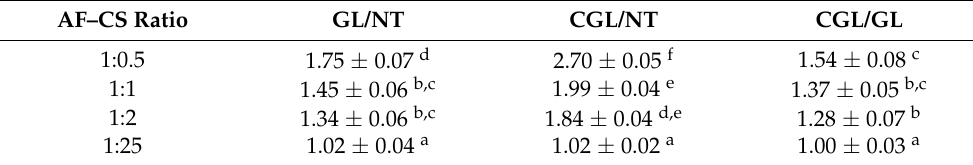
Table 1. Polyphenol sorption yields (Y P ) ratios from NT, GL and CGL assayed methods. AF–CS Ratio